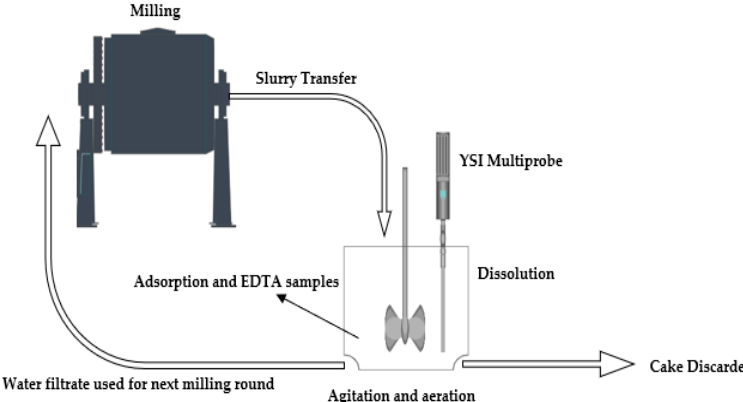
Figure 2. Dissolution loop protocol and dissolved oxygen demand test.